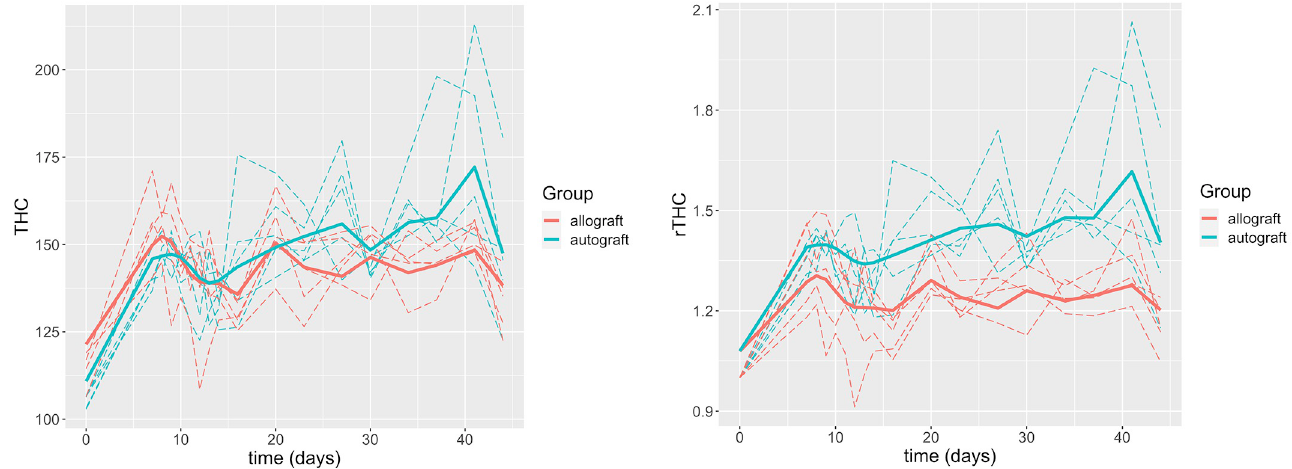
Fig 5. (a) Estimated THC trajectories over time by SMM (thick curves) for the allograft group (red) and the autograft group (blue) at γ = 0.5. The dashed curves are the observed THC trajectories of individual mice in each group. (b) Estimated rTHC trajectories over time by SMM (thick curves) for the allograft group (red) and the autograft group (blue) at γ = 0.5. The dashed curves are the observed rTHC trajectories of individual mice in each